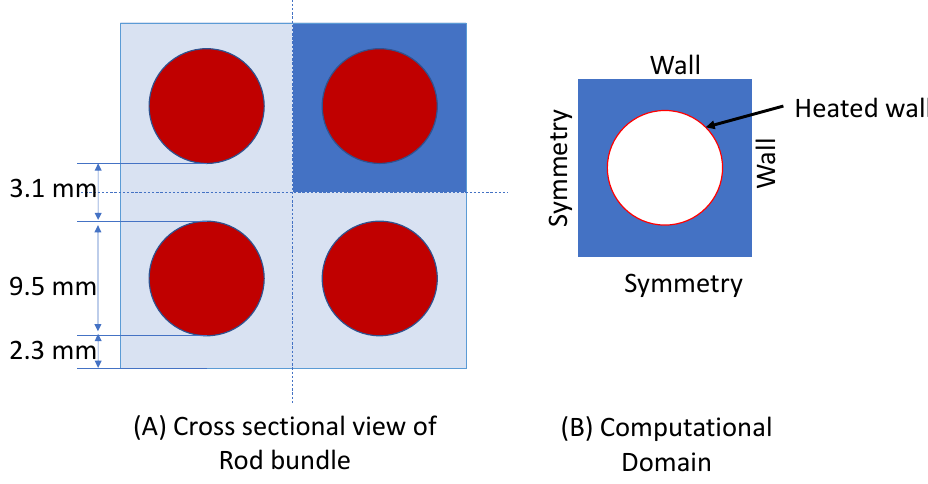
Figure 4. Geometry and boundary conditions (square lattice).